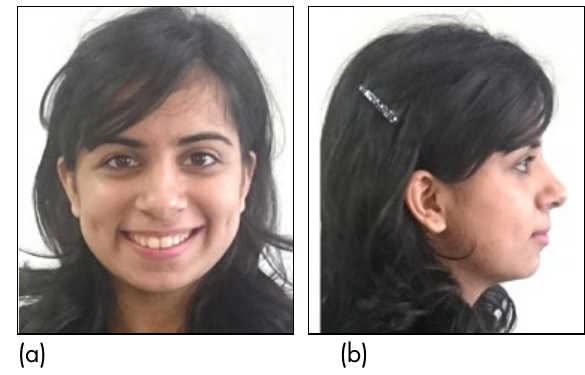
Figure 8 (a, b). Post-retention extra-oral Table I. Cephalometric measurements.